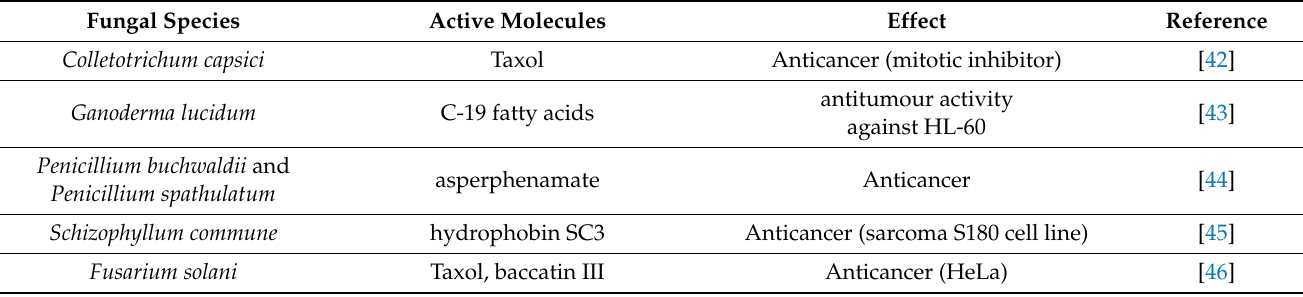
Figure 1. Schematics overview of edible mushroom contribution to human health. Table 1. Examples of major compounds from fungi and their main potential benefits to human health reported between 2010 and